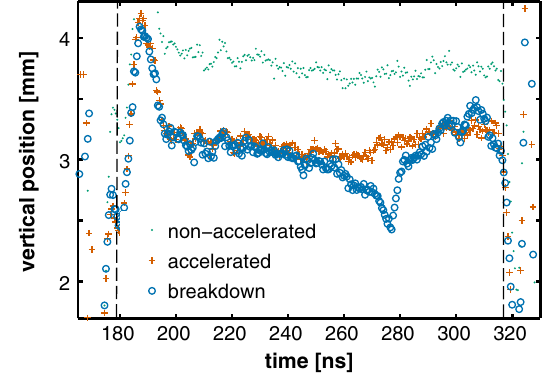
FIG. 6. Vertical beam position measurements corresponding to a nonaccelerated bunch train at the top, an accelerated one in the middle, and one corresponding to a rf breakdown during the acceleration at the bottom. The bleep in the bottom signal corresponds to the effects of a short breakdown that displaces downwards the beam position.